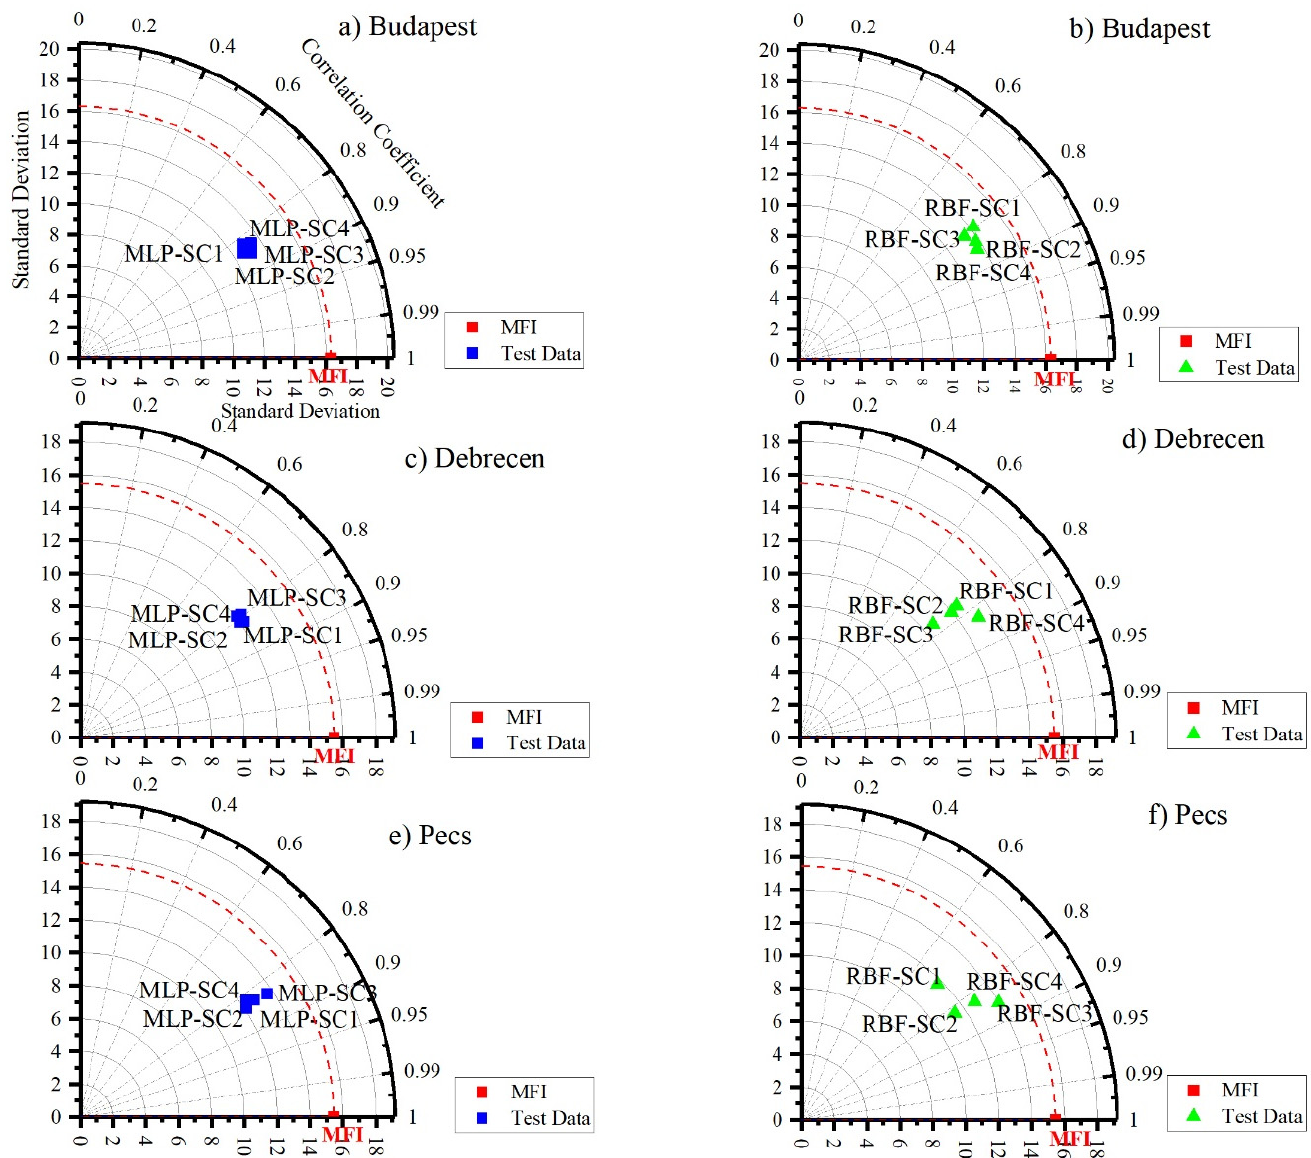
Figure 8. Taylor diagram for assessing the performance of ANN (MLP and RBF) algorithms in pre- predicting MFI . ( a , b ) Budapest. ( c , d ) Debrecen. ( e , f ) dicting MFI. ( a , b ) Budapest. ( c , d ) Debrecen. ( e , f ) Pecs.